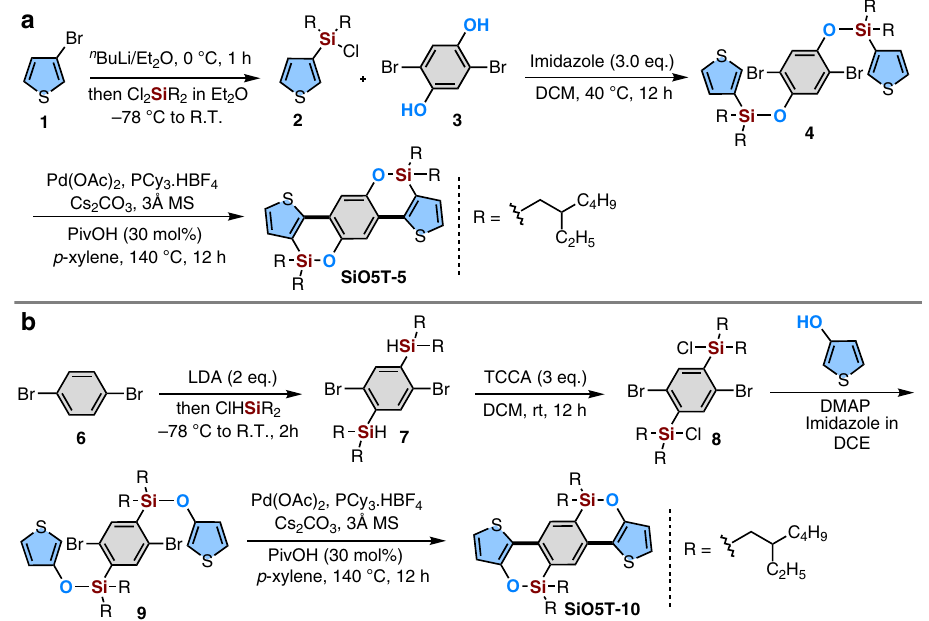
Fig. 2 Synthetic routes for the SiO-bridged ladder-type π -skeletons. a The route for producing ladder-type π -skeleton SiO5T-5 . b The route for producing ladder-type π -skeleton SiO5T - 10 .